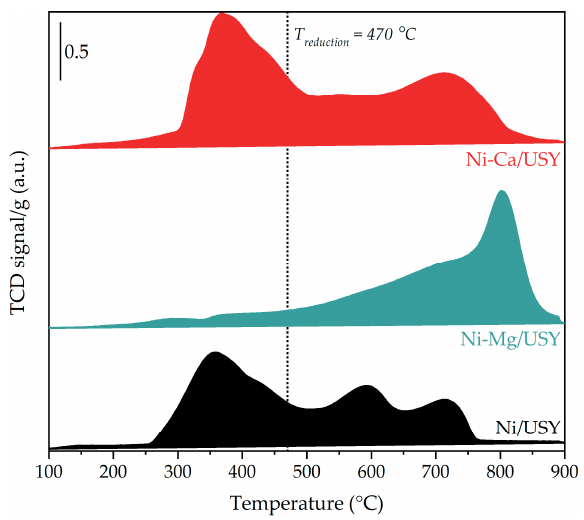
Figure 7. H 2 -TPR profiles obtained for Ni-AE/USY catalysts.